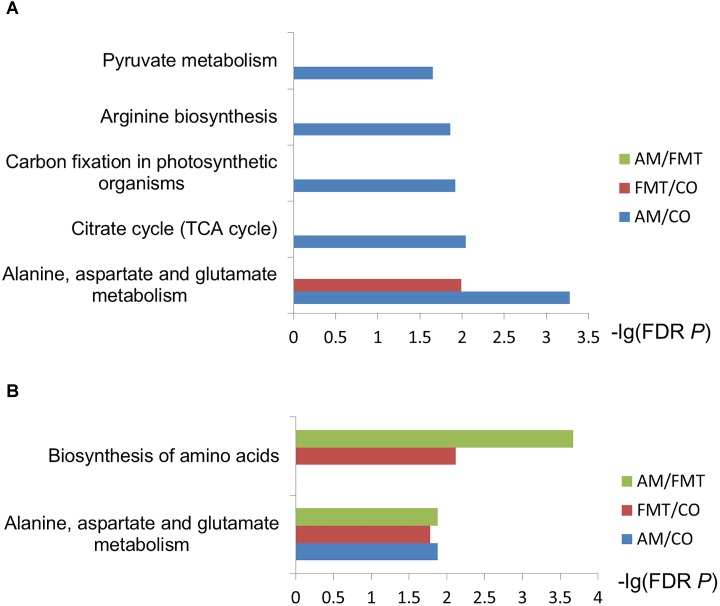
Enrichment analysis of selected metabolites. The metabolites discriminated among the amoxicillin (AM), fecal microbiota transplantation (FMT) and control (CO) groups on day 7 (A) and day 21 (B) were used for the metabolite set enrichment analysis based on the online analysis tool of Smart Nuclide Corporation. The rectangle color represents contrast, and the rectangle length is the false discovery rate-adjusted P-value.